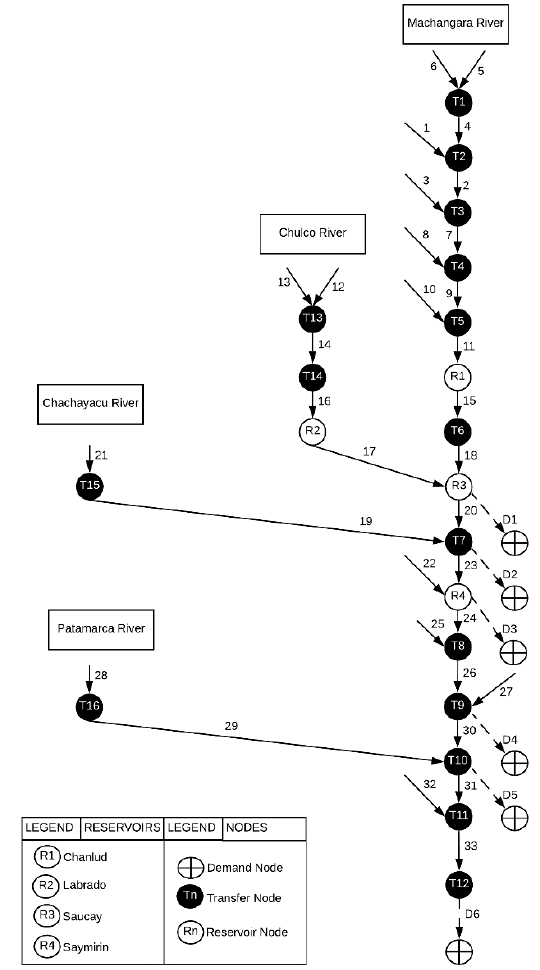
Figure 7. The final network configuration of the Machángara River system.